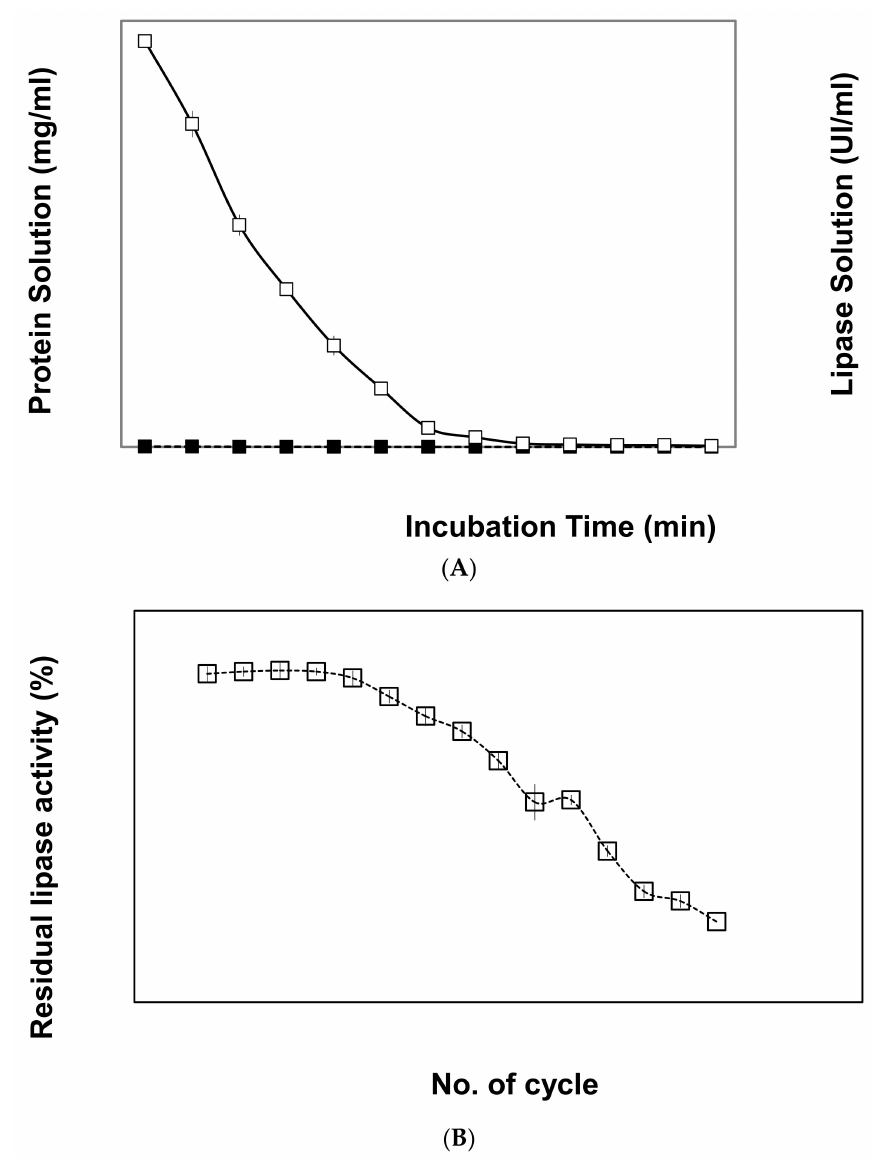
Figure 2. ( A ): Adsorption kinetics of B. stearothermophilus lipase (open boxes) and protein (closed boxes) on CaCO 3 . Enzyme activity was measured using a pH-stat at pH 12 and 60 ◦ C with an olive oil emulsion as the substrate. Data are expressed as the mean ± standard deviation of triplicate mea- surements. ( B ): Residual enzyme activity following repeated use of immobilized B. stearothermophilus lipase. Data are expressed as the mean ± standard deviation of triplicate